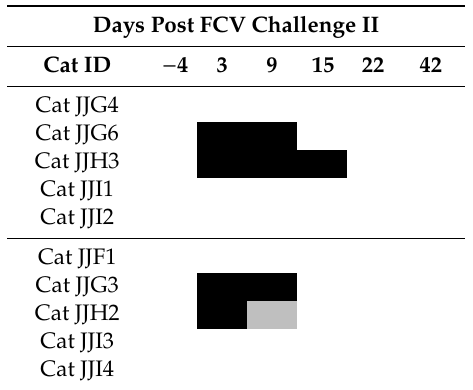
Table 3. Oropharyngeal shedding of FCV after the second experimental